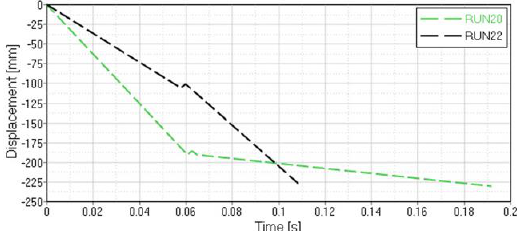
Figure 13. Reaction force curves comparison between RUN20 and RUN22; blank0.